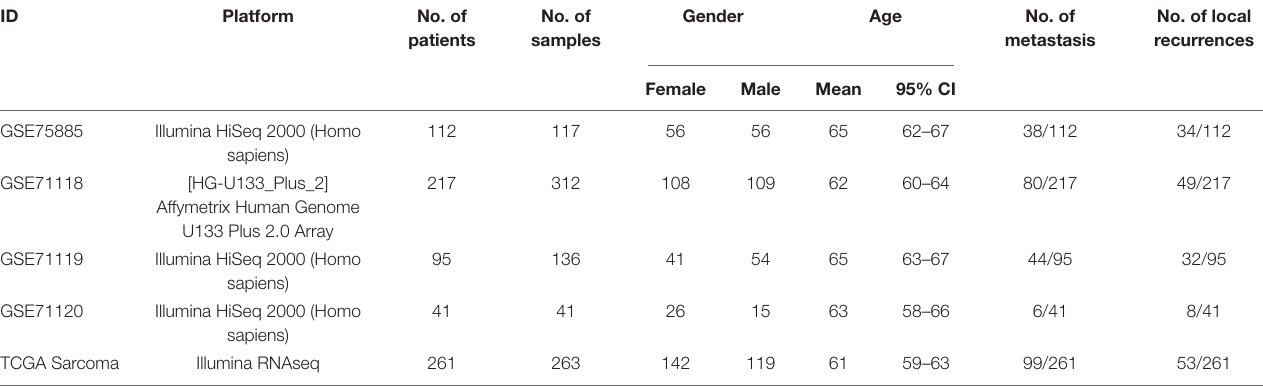
TABLE 1 | Basic characteristics of patients used for estimating fractions of TME